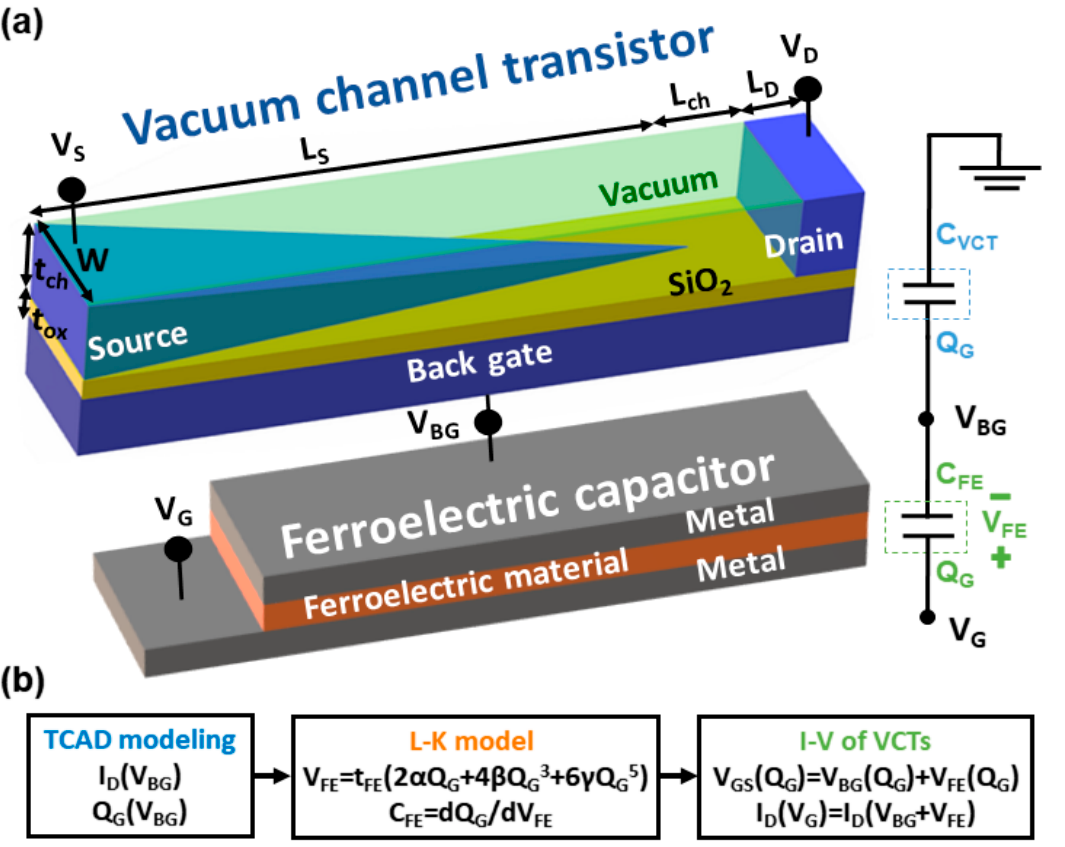
Figure 1. ( a ) Bird’s eye view of the proposed negative capacitance vacuum channel transistor and its equivalent capacitor network model. The channel length ( L ch ), source length ( L S ), drain length ( L D ), and width ( W ) are 10 nm, 200 nm, 10 nm, and 30 nm, respectively. ( b ) Simulation procedure of negative capacitance vacuum channel transistors combining technology computer-aided design (TCAD) simulation results with the Landau–Khalatnikov (LK) equation.